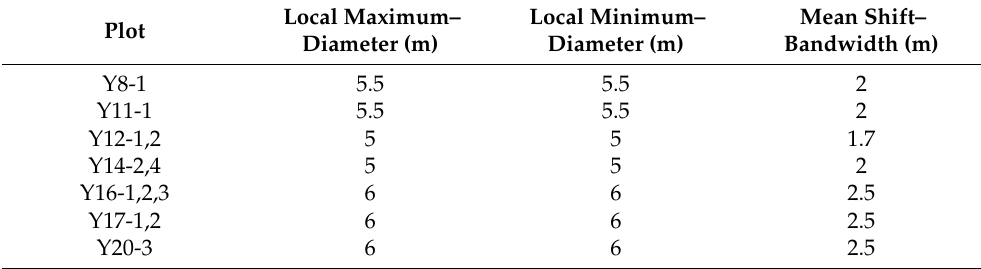
Figure 4. ITD and seed extraction through a local maximum algorithm ( a ), a local minimum algorithm ( b ), and a Mean Shift algorithm ( c ) in plot Y16-3 as an example. The yellow dots are seed points extracted by the algorithm in ( a ); the purple dots are seed points extracted by the algorithm in ( b ); the blue dots are seed points extracted by the algorithm in ( c ). Table 2. Parameters of three ITD methods among sample plots in the leaf-off season. (Local Maximum: a local maximum filter algorithm on the CHM; Local Minimum: A local minimum filter algorithm on the normalized point cloud data; Mean Shift: a local density maxima detecting algorithm on the horizontal point cloud